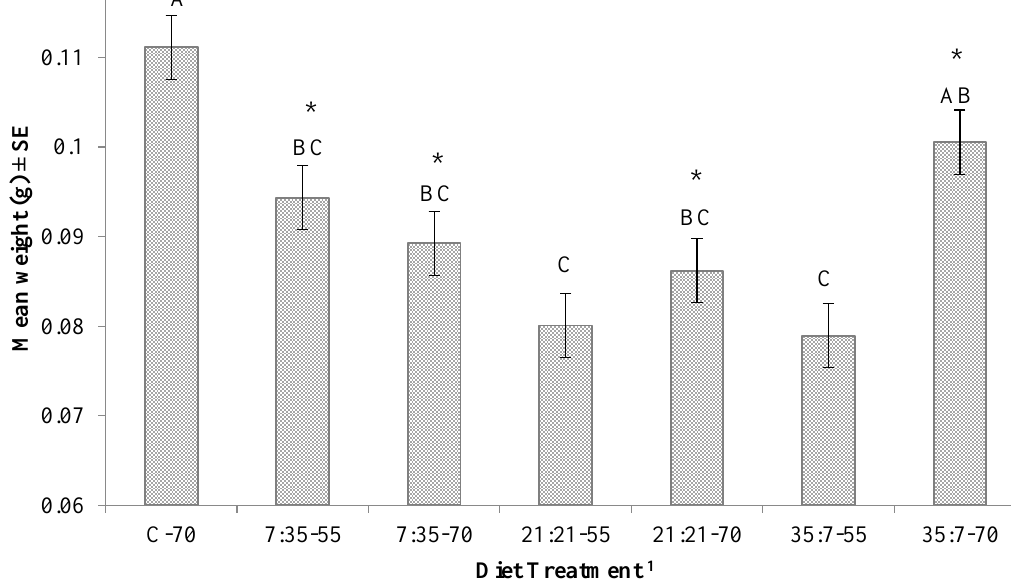
Figure 2. Mean weight (g) of black soldier fly prepupae produced on a diet treatment in an incubator set at 30 °C, 70% RH, on a 14L:10D cycle. Letters indicate significant differences (ANOVA followed by Tukey–Kramer HSD, α = 0.05). 1 Treatments are presented as protein:carbohydrate-moisture; * indicates significant difference between trials.